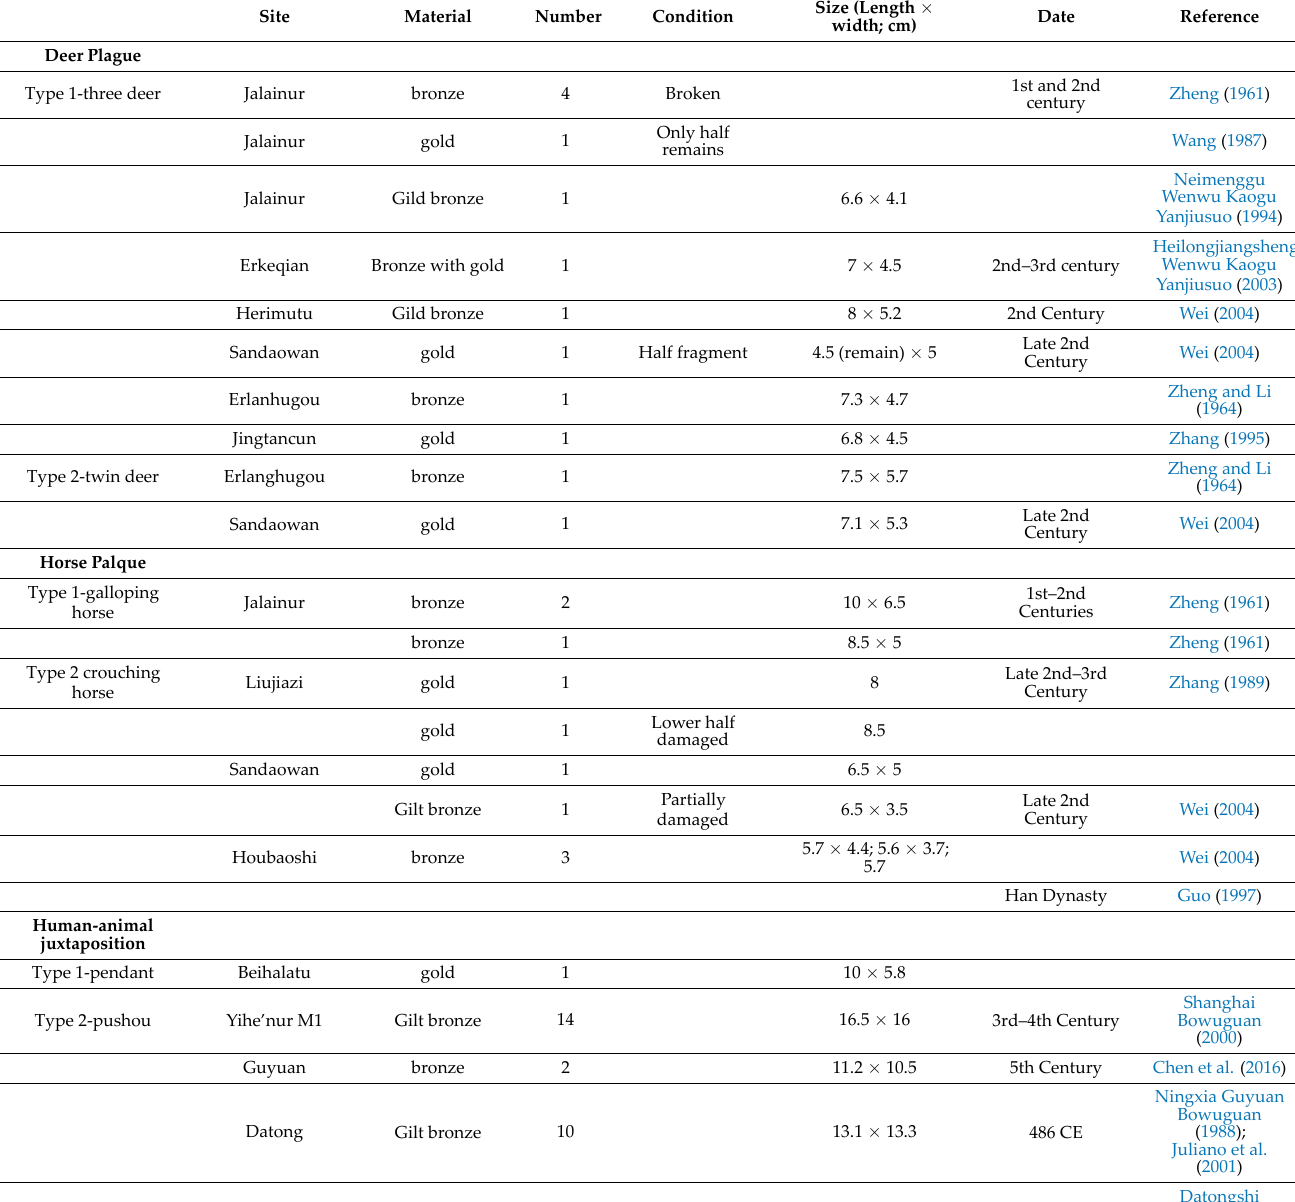
Table 1. Excavated Xianbei Zoomorphic Metal